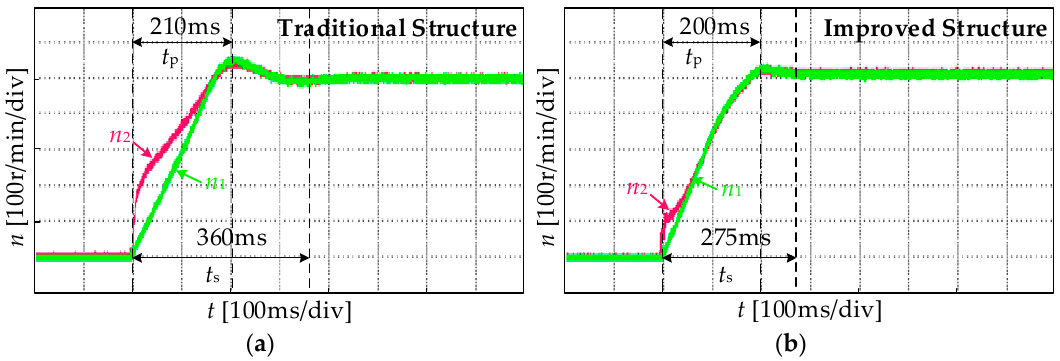
Figure 14. Output speed during the start-up of motors with load: ( a ) Output speed in the traditional structure; ( b ) Output speed in the improved structure.